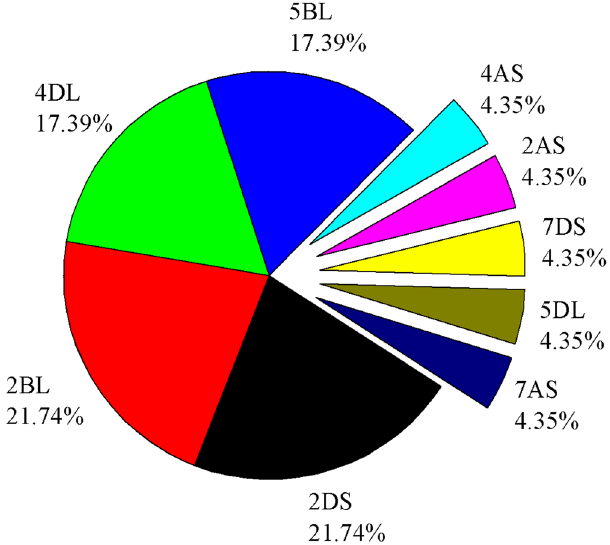
Figure 5. Distribution of the identified TaTIF Y TF genes on wheat